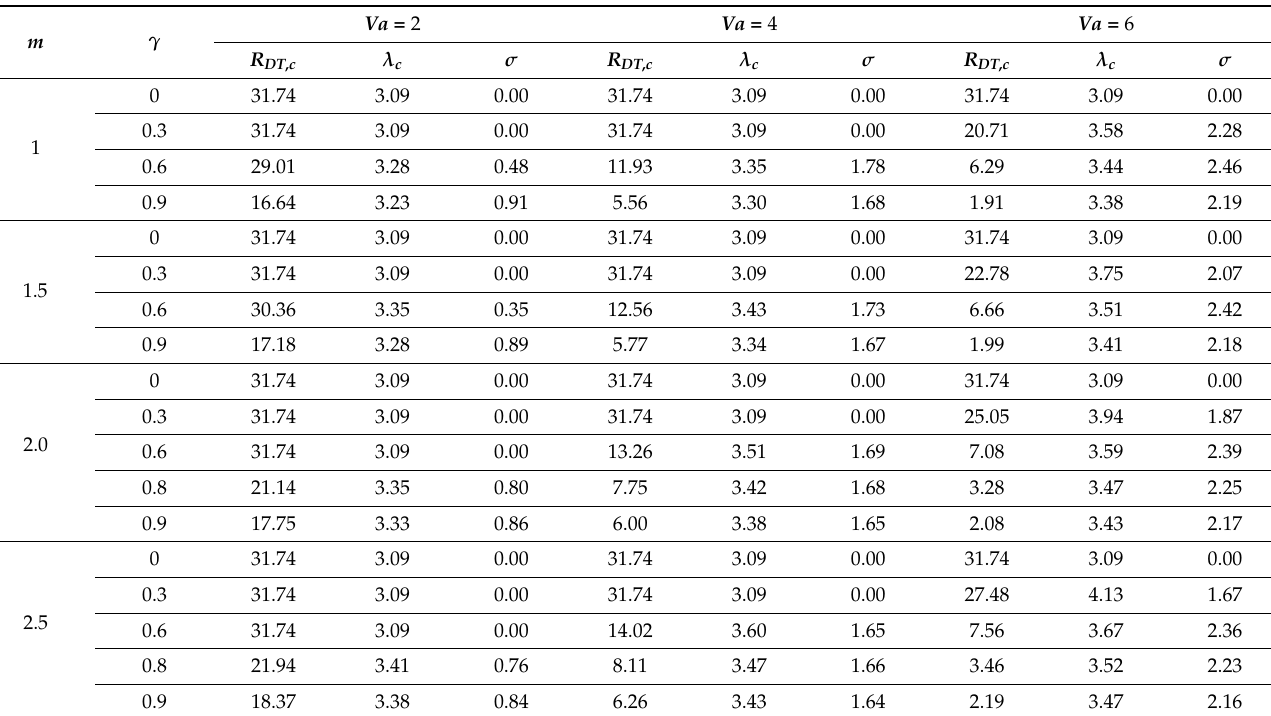
Table 3. Comparison of R DT , c , λ c , and σ for diverse values of γ , m , and Va at Le = 2, m = 1.5, A = 1,